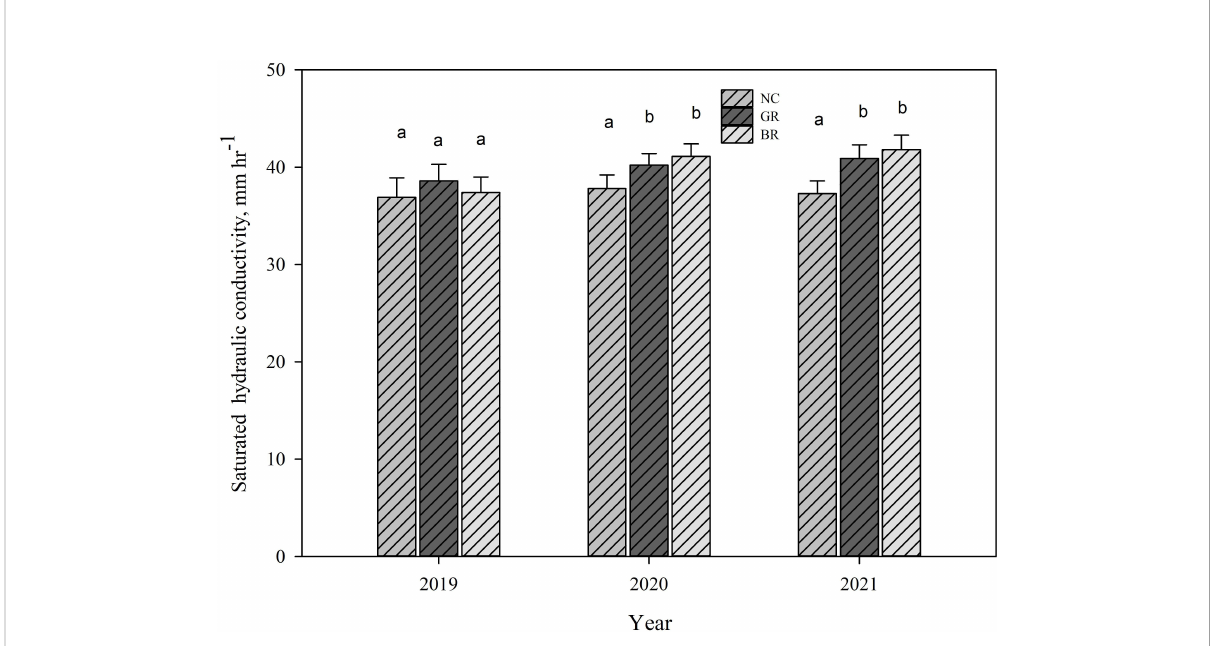
FIGURE 5 Saturated hydraulic conductivity measured in spring 2019, fall 2020 and fall 2021 in rye soybean rotation study at Stoneville, MS, USA in no cover crop (NC), green rolled rye followed by desiccation (GR) and desiccation of rye crop followed by soybean planting (BR) plots. Means separation was done by LSD and different letters indicate signi fi cant differences among